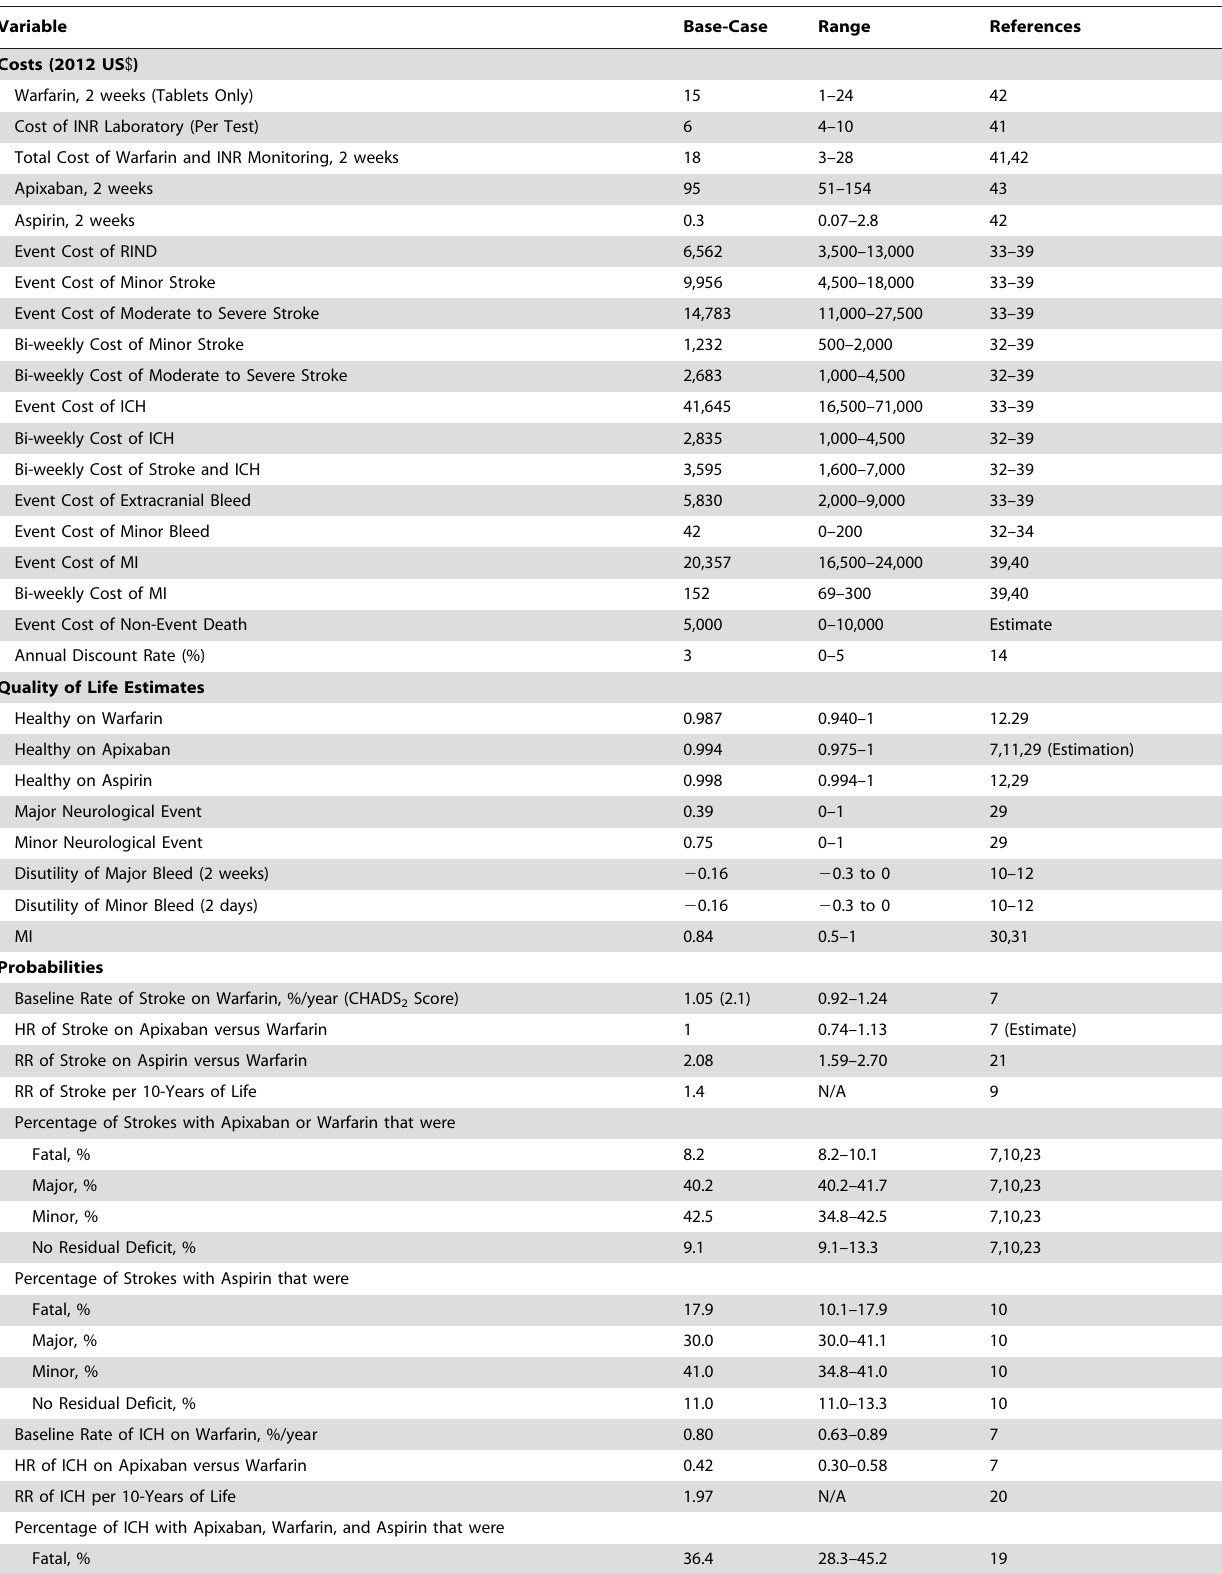
Table 1. Base-Case Model Variables and Ranges Used in Sensitivity